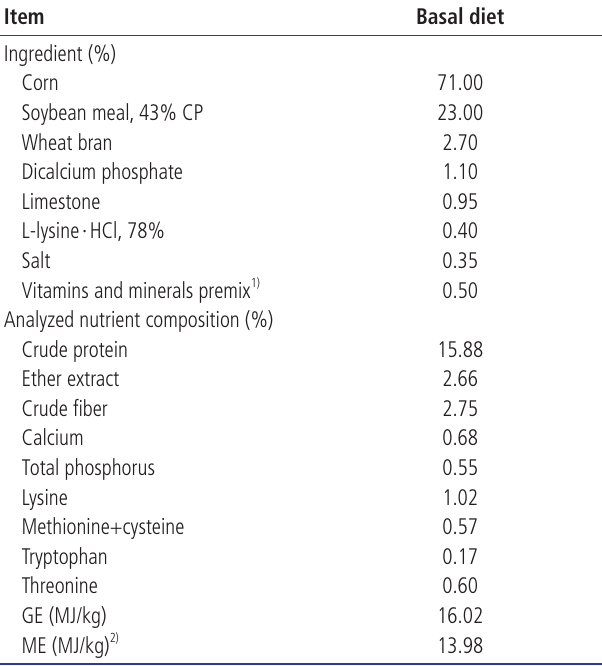
Table 1. Ingredient and analyzed nutrient composition of the experimental diet (as-fed